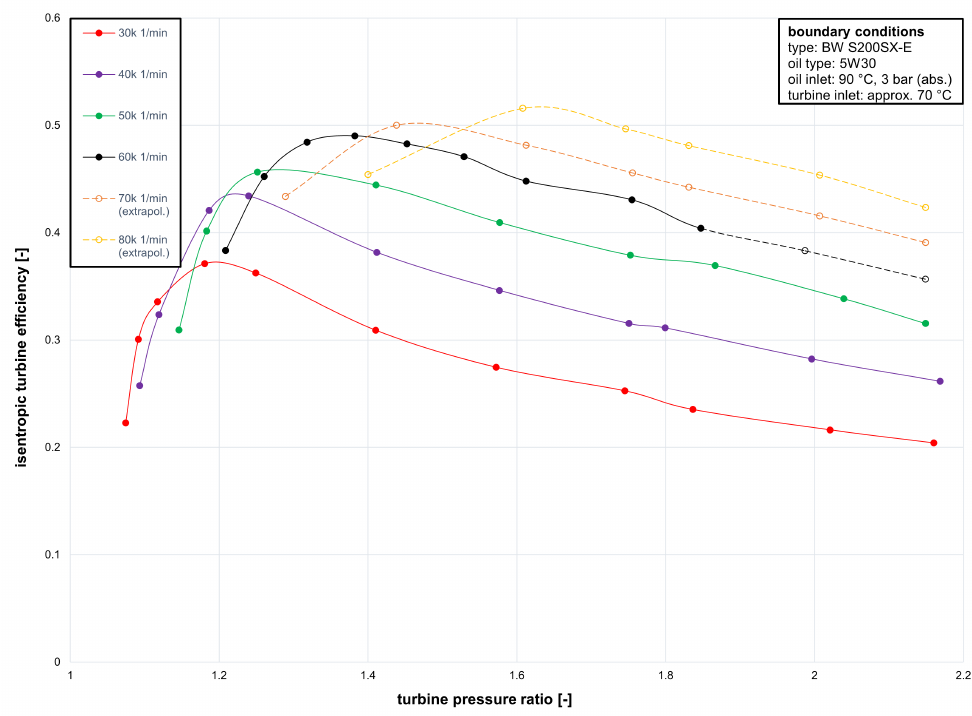
Figure 12. HGTB–turbine pressure ratio over isentropic turbine efficiency with adapted turbine components of an